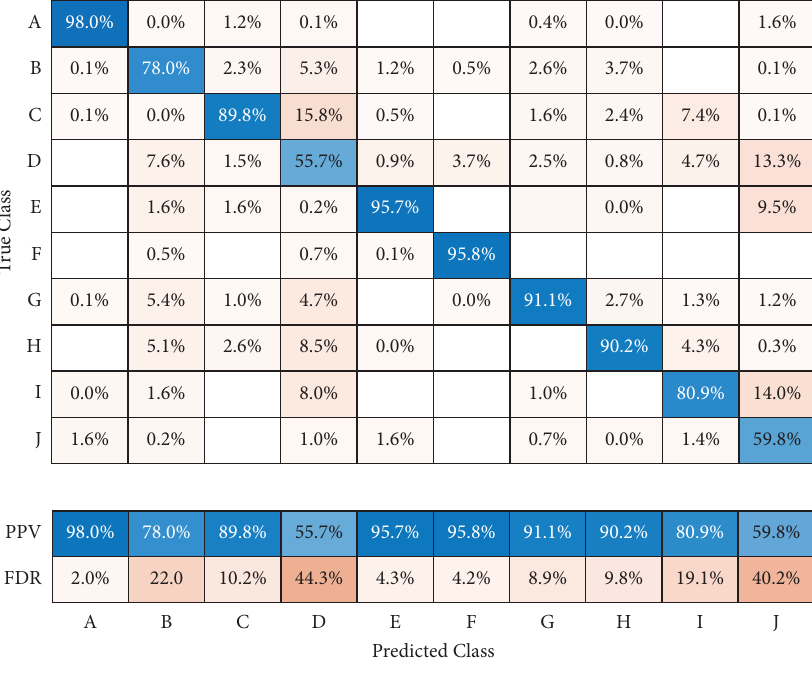
Figure 10: Confusion matrix with PPV vs. FDR for 15-feature